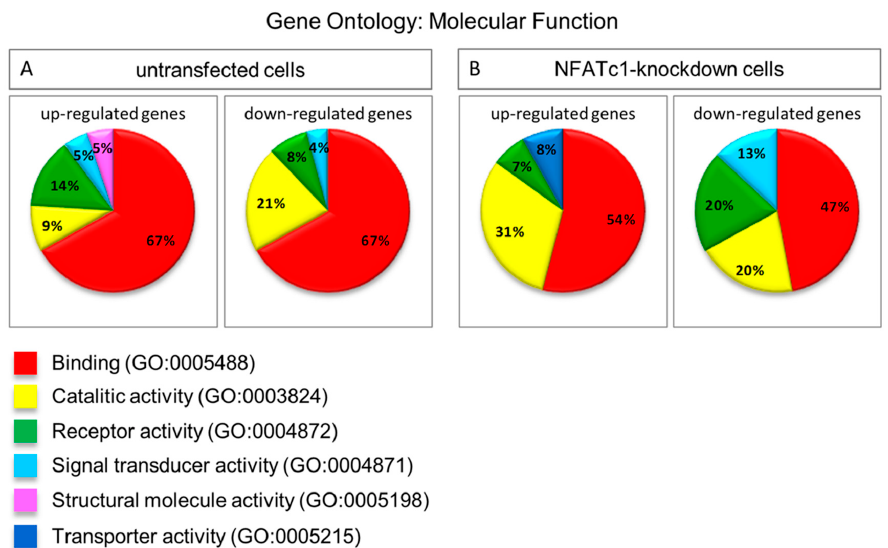
Figure 4. Gene Ontology analysis as molecular function of untransfected and NFATc1-knockdown cells. Gene Ontology analysis as molecular function represented by pie chart ( A ) untransfected cells, RANKL-induced; and ( B ) NFATc1-knockdown cells, RANKL-induced.